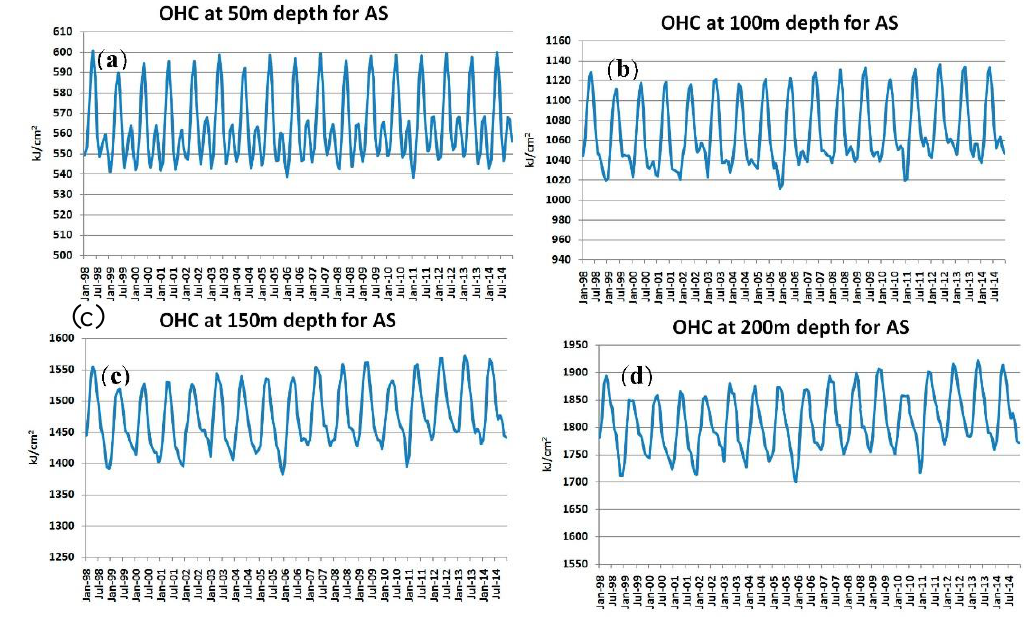
Figure3. Time series of the North Indian Ocean (NIO) ocean heat content(OHC) from 1998 to 2014 for surface to ( a ) 50m, ( b ) 100m, ( c ) 150m, and ( d ) 200m depth.